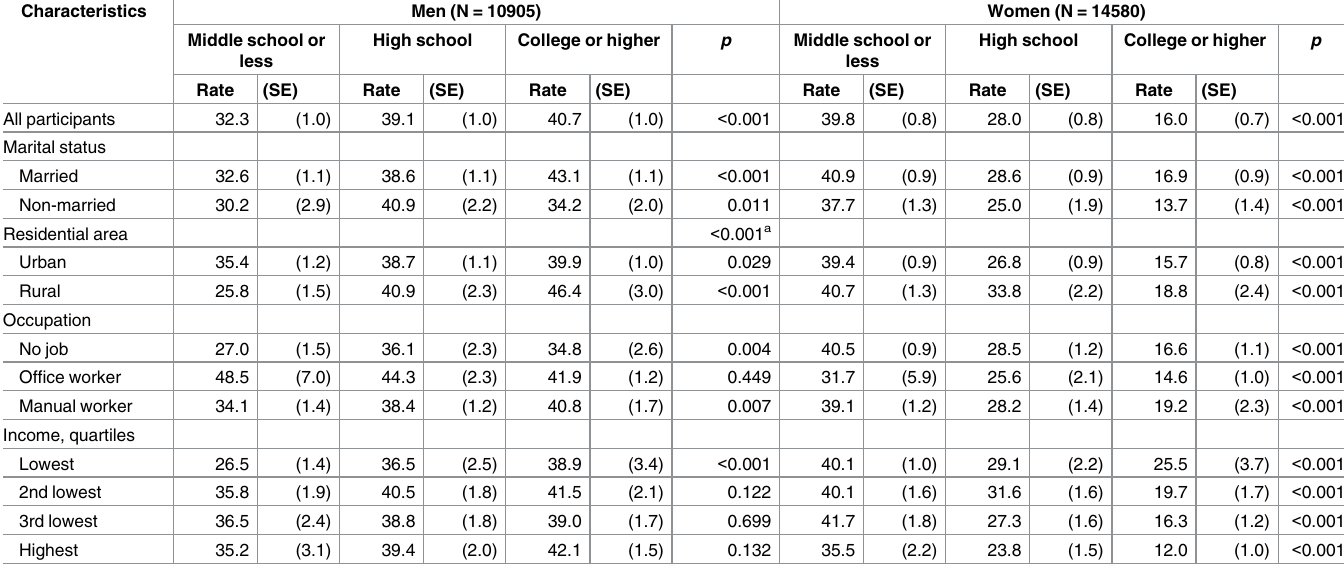
Table 2. Percentage of obesity in each socioeconomic status indicator group by sex and educational level. Characteristics